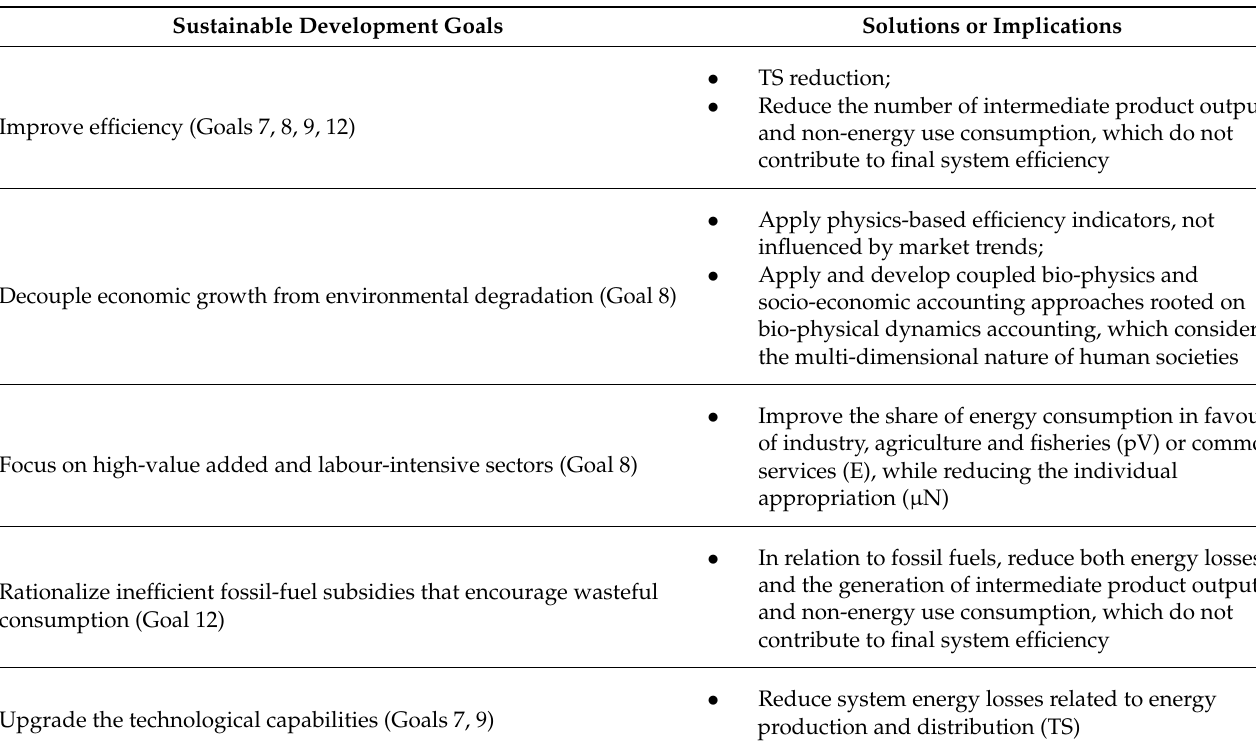
Table 9. Extracts from Sustainable Development Goals, directly related to energy, with solutions or implications derived from this paper, with special reference to Equation (1) and Figure